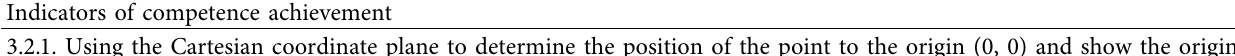
Table 2: The snippet of ICA made by